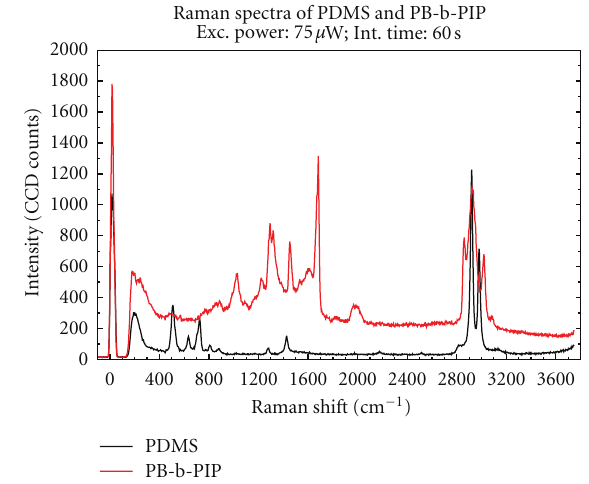
Figure 4: Raman spectra of bulk PDMS and